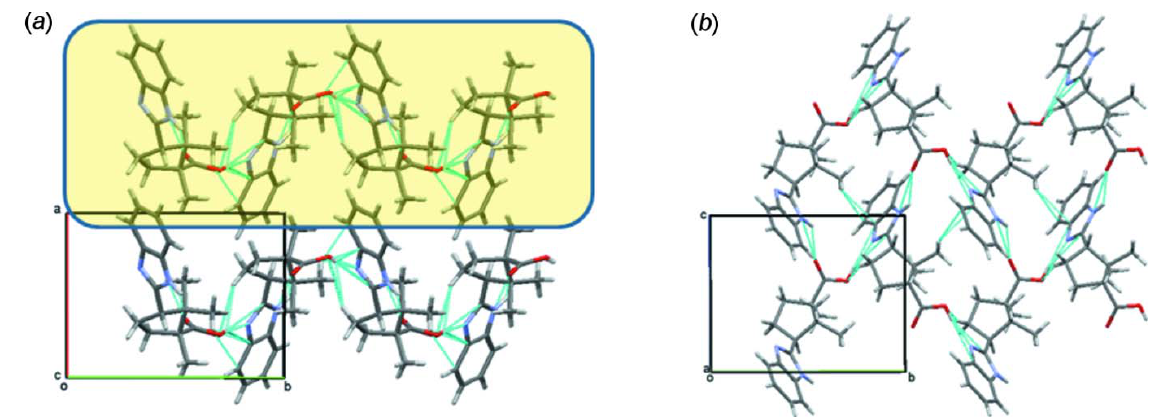
Figure 4 ( a ) View of the structure of compound 4 down the b axis and ( b ) hydrogen bonds within a layer in the crystal of 4